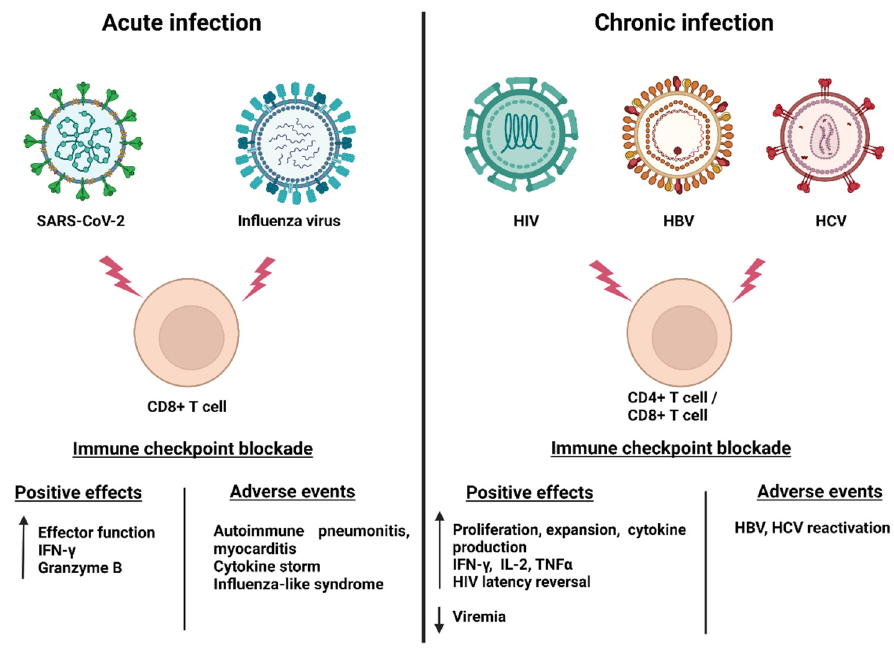
Figure 2. Effects of ICB therapy in chronic and viral infections. ICB: immune checkpoint blockade.